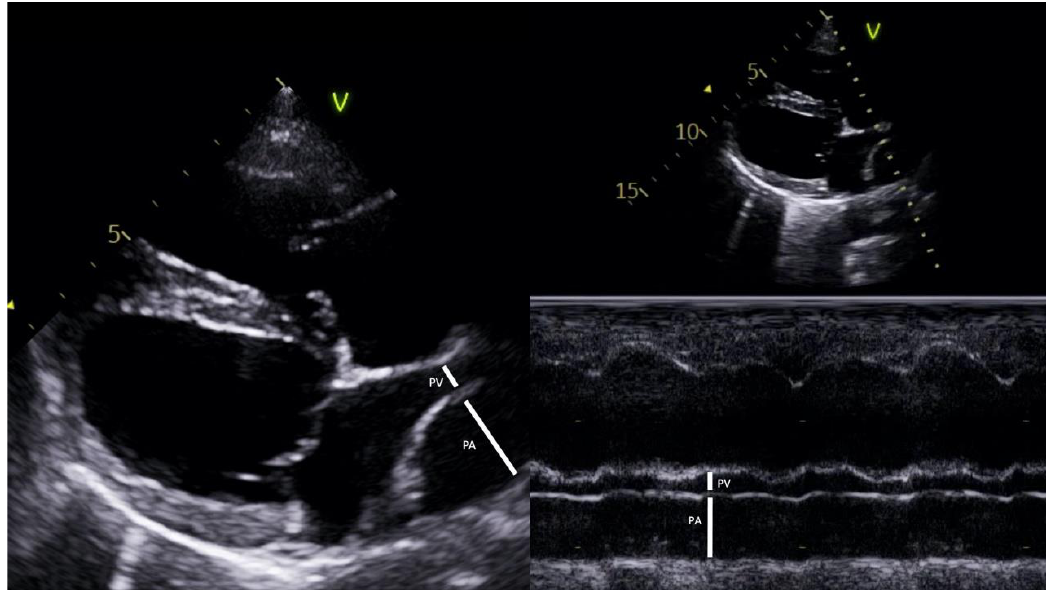
Figure 1. The image shows representative measurement and calculation of the pulmonary vein (PV) to pulmonary artery (PA) ratio in two-dimensional (2D) and time – motion mode (M mode) echocardiography. PV:PA ratio (2D and M mode) was obtained in a heartworm-infected dog with an RPAD index < 29.5% (Right parasternal long axis four-chamber